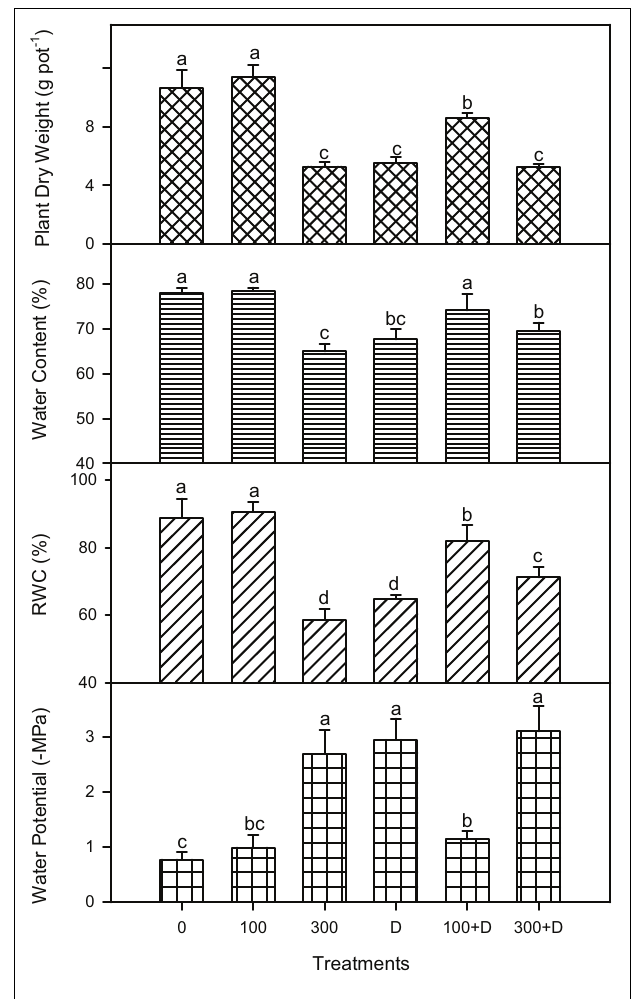
FIGURE 1 | | Plant biomass and water relations under salinity, drought, and a combination of both treatments. Mean ± SE ( n = 3) of plant dry weight (in grams per pot), leaf water content (percent of fresh weight), relative water content ( RWC , in percent), and leaf water potential (in megapascals) for treatments of 0, 100, and 300 mM NaCl, drought (D), and a combination of salinity and drought [100 and 300 mM NaCl + drought (100 + D and 300 + D, respectively)]. Different letters denote, after Bonferroni post hoc test, significant difference ( P <